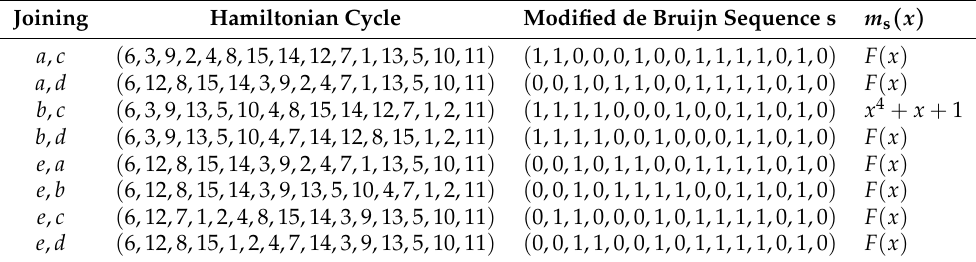
Figure 3. The associated graph G Ψ for Example 6. Table 4. The eight Hamiltonian cycles produced from Ψ by cycle joining in Example 6. For n = 4, we have F ( x ) = 1 + x + x 2 + . . . + x 14 . The edges a , b , c , d and e are specified in Figure